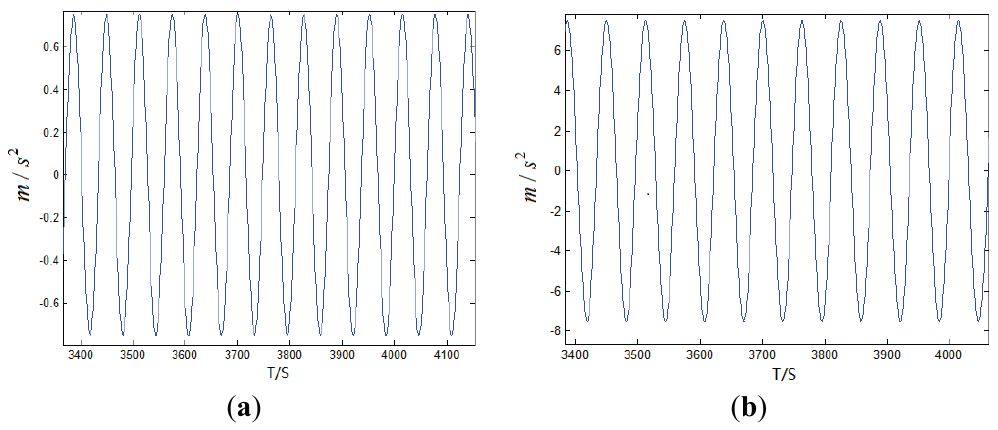
Figure 7. ( a ) The change rate of north velocity; ( b ) The change rate of east velocity. In the whole simulation time, the change rate of velocity varies over time, as shown in Figure 7, and the traditional damping technology without using external reference information cannot apply to this condition.